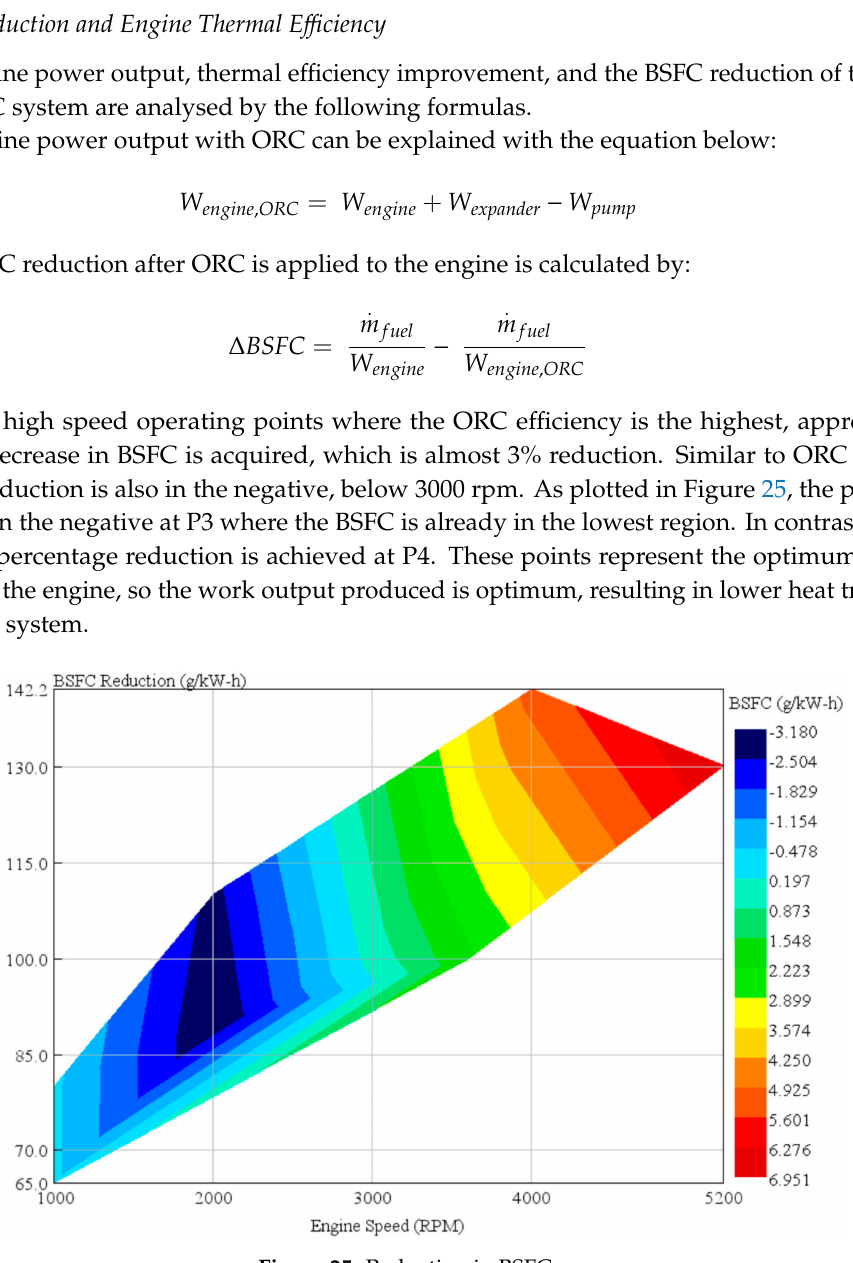
Figure 25. Reduction in